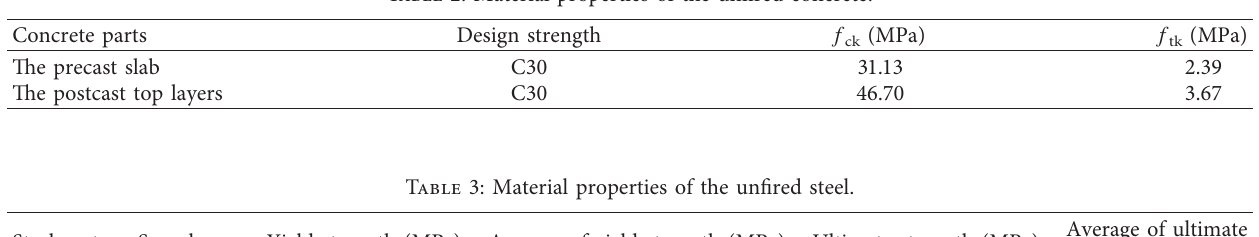
Table 2: Material properties of the unfired concrete.